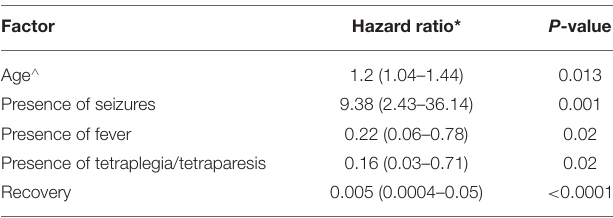
TABLE 1 | Factors influencing survival of dogs diagnosed with tick born